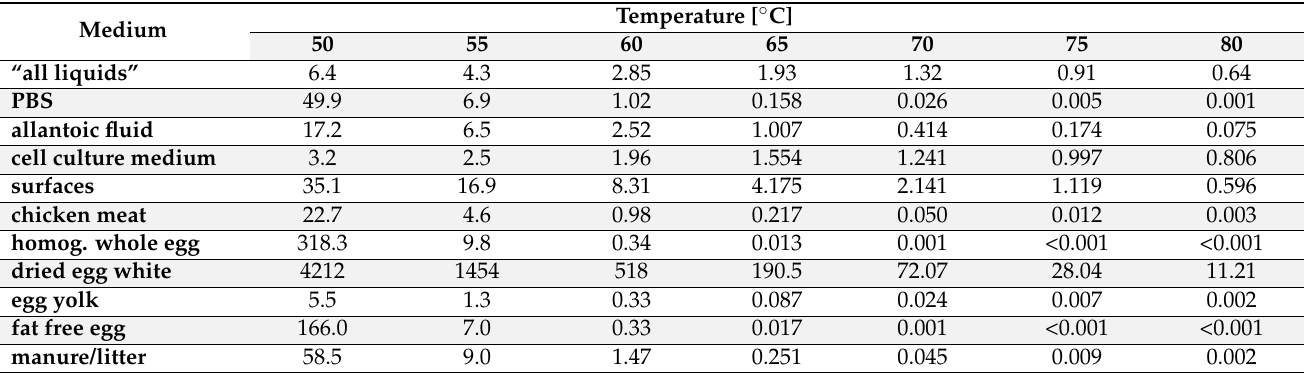
Table 2. Expected decimal reduction times in minutes for different temperatures and media, deter- mined using the previously determined equations for decimal reduction